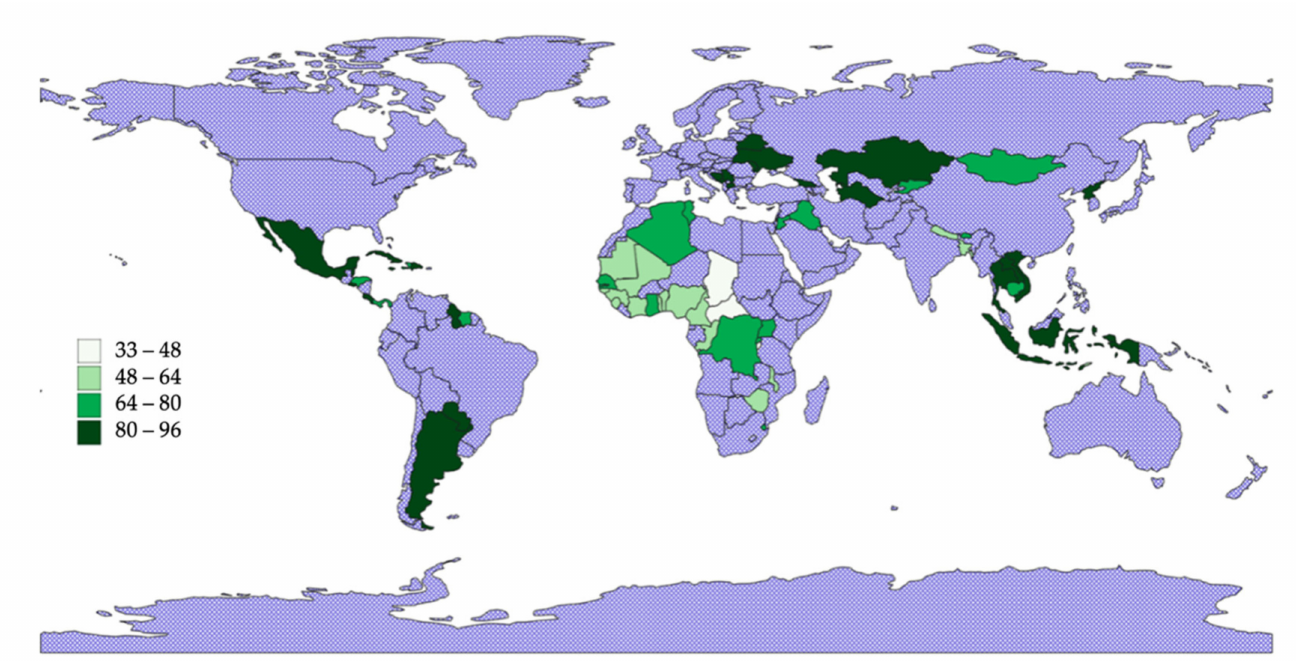
Figure 1. Early Childhood Development Index (ECDI) levels in the sampled countries ( N = 68 LMICs). Note: Blue area stands for either missing or high-income